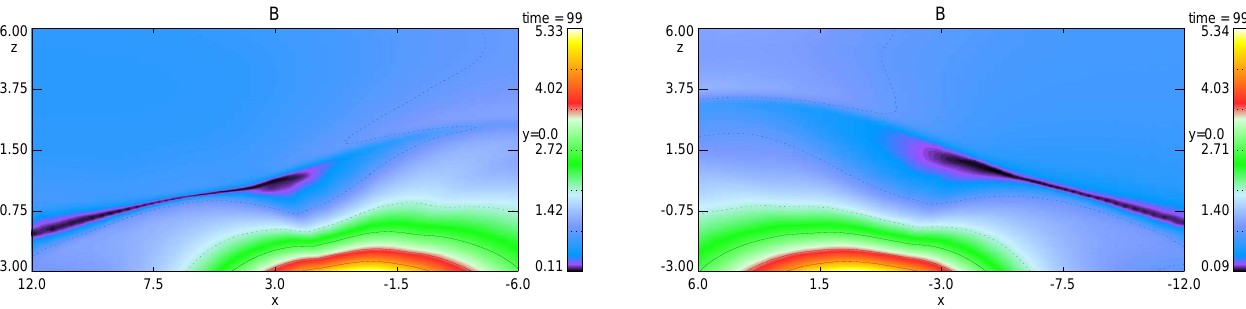
Fig. 3. Total magnetic field strength indicating diamagnetic regions plotted near the noon-midnight meridian plane for the cases of strongly southward IMF (left) and strongly northward IMF